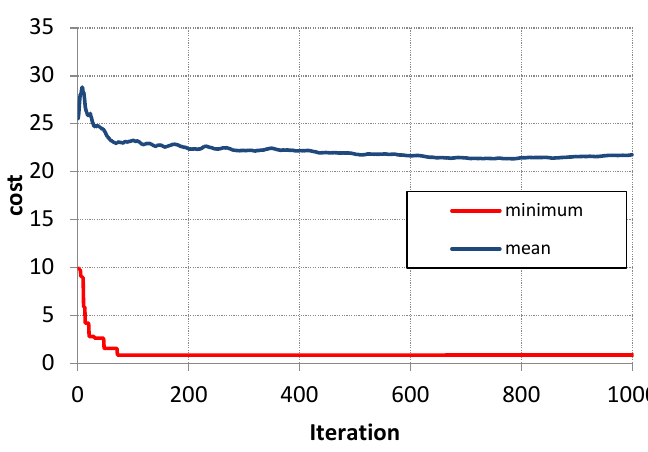
Figure 5. The convergence of the objective function towards the optimized value for the suggested equation